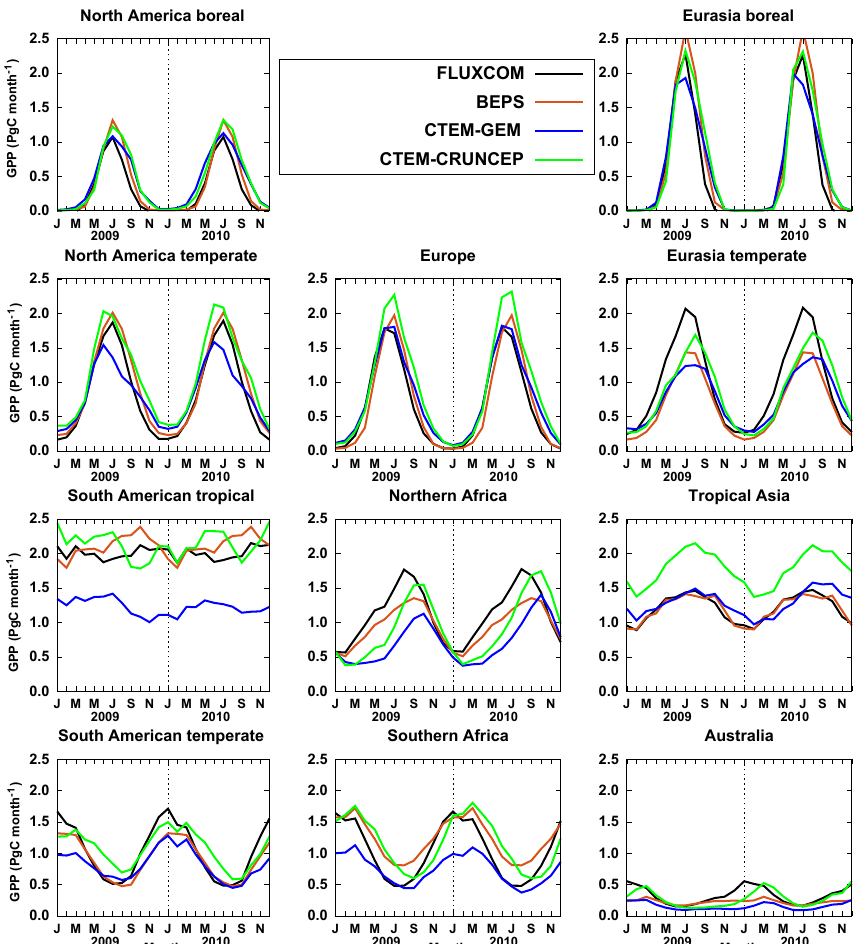
Figure 8. The seasonal cycle of GPP from CTEM-GEM, CTEM-CRUNCEP, BEPS, and FLUXCOM integrated over the 11 TransCom land